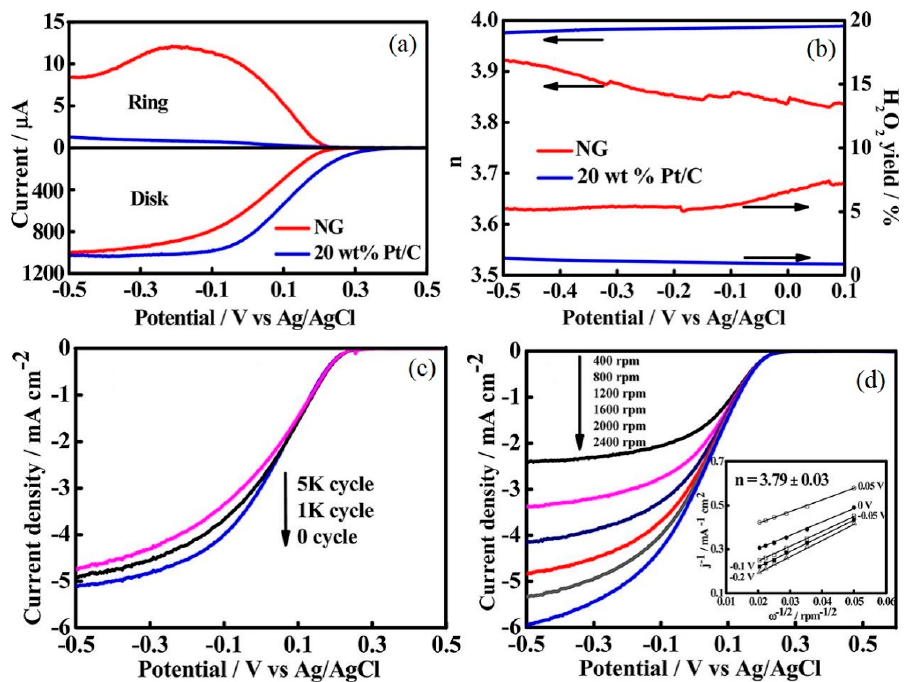
Figure 10. Variation of disk and ring currents on nitrogen-doped graphene (NG) cathode and Pt/C cathode as a function of the potential at a rotation rate of 1600 rpm ( a ); and the corresponding H 2 O 2 yield and electron transfer number ( n ) as a function of the potential ( b ). Polarization curves ( j -V relationship, where j is represent for the current density) of oxygen reduction reaction (ORR) at NG cathode ( c ) after varying the potential cycles at a rotation rate of 1600 rpm, and ( b ) at varied rotation rates after 5000 cycles, inset ( d ) shows the Koutecky-Levich ( K - L ) plots. Adapted from [50], with permission from © 2013 American Chemical Society.